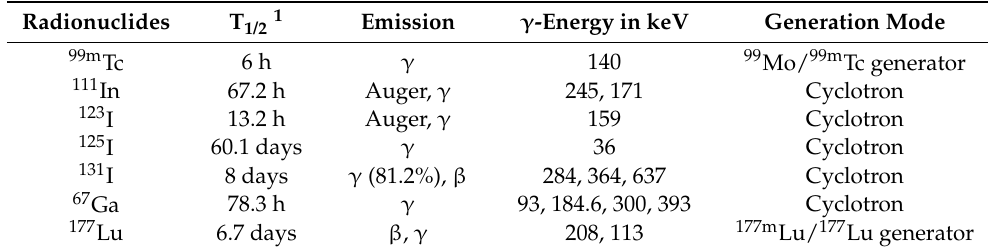
Table 1. List of radionuclides used for SPECT imaging [26–28].